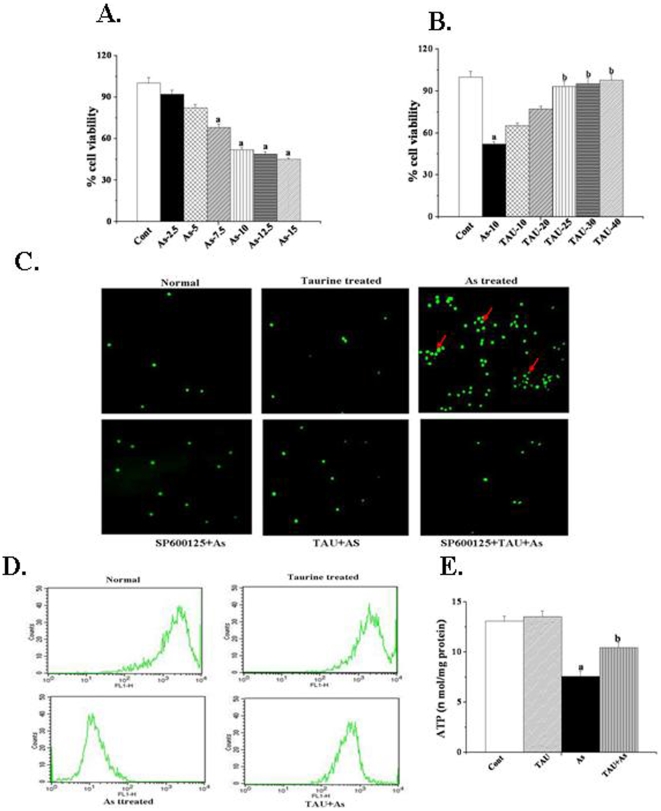
Impact of As and taurine on cell viability, ROS production, Δψm and intracellular ATP levels.Panel A: Dose dependent effect of As on cell viability; Panel B: Dose dependent effect of taurine on As treated hepatocytes; Cont: cell viability in normal hepacytes; As-2.5, As-5, As-7.5, As-10, As-12.5 and As-15: cell viability in As treated hepatocytes for 8 h at a dose of 2.5, 5, 7.5, 10, 12.5 and 15 µM; TAU-10, TAU-20, TAU-25, TAU-30, and TAU-40: cell viability level in hepatocytes treated with taurine (1 h prior to As addition) and As for 8 h at a dose of 10, 20, 25, 30 and 40 mM. Panel C: The intracellular ROS production was detected by DCF-DA method in As treated hepatocytes in absence (As) and presence of taurine (TAU+As). SP600125+As: ROS production in hepatocytes treated with 10 µM SP600125 15 minutes before As exposure and incubated for 8 h, SP600125+TAU+As: ROS production in hepatocytes treated with 10 µM SP600125 and 25 mM taurine 15 minutes before As exposure and incubated for 8 h. Arrows indicate fluorescent dye, DCF uptake by hepatocytes. We have taken equal number of cells in each set as observed in microscope under bright field. Panel D: mitochondrial membrane potential (Δψm) was measured using a fluorescent cationic probe rhodamine-123 by flow cytometer with FL-1 filter. Results represent one of the six independent experiments. Panel E: Effect of taurine on As-induced decrease in intracellular ATP levels. CON, ATP levels in untreated hepatocytes; As: ATP levels in hepatocytes treated with As; TAU+As: ATP levels in hepatocytes treated with taurine along with As. “a” indicates the significant difference between the normal control and toxin-treated cells, “b” indicates the significant difference between toxin control and taurine-treated cells. Each column represents mean ±SD, n = 6; (pa<0.05, pb<0.05).